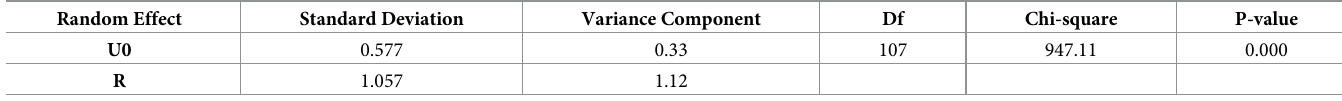
Table 2. Parameter estimation of null model on the per capita cycling frequency of